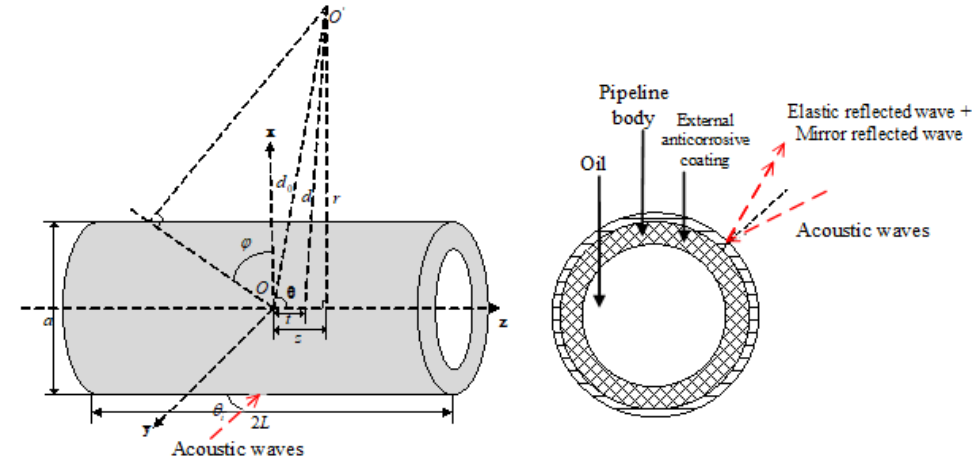
Figure 3. Underwater metal pipe shedding damage model.